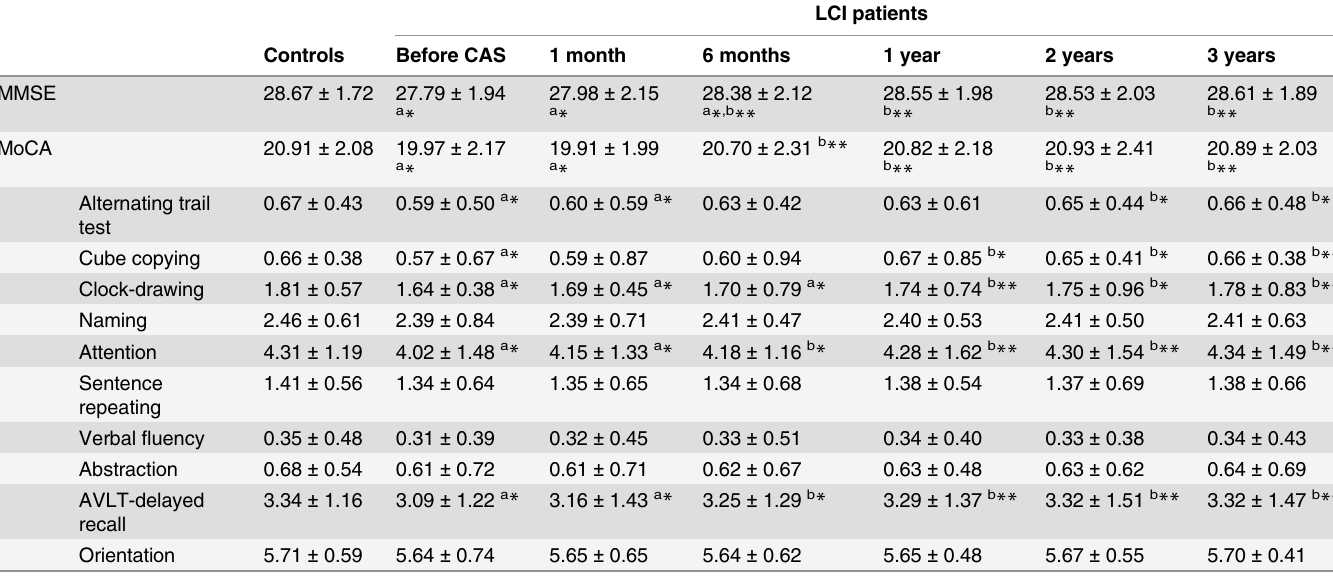
Table 2. MMSE and MoCA scores of CLI and healthy controls.